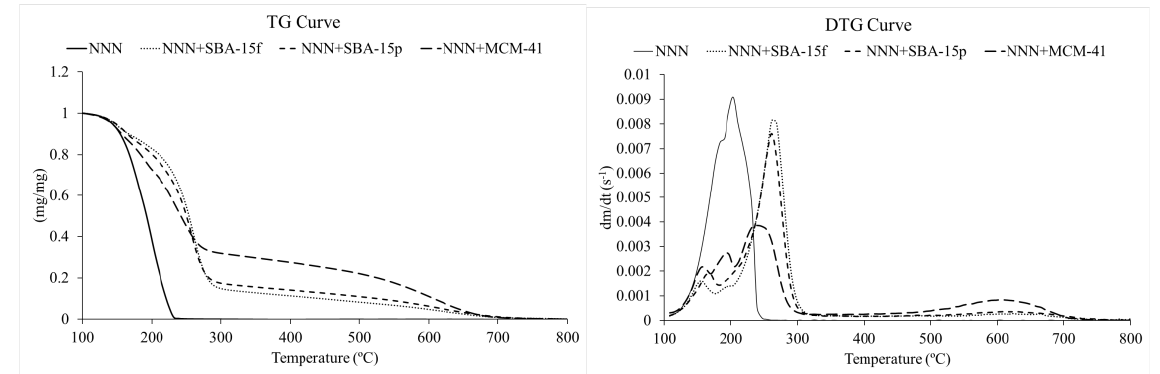
Figure 4. TG and DTG curves for experiments with NNN and NNN with three catalysts under oxidizing atmosphere.